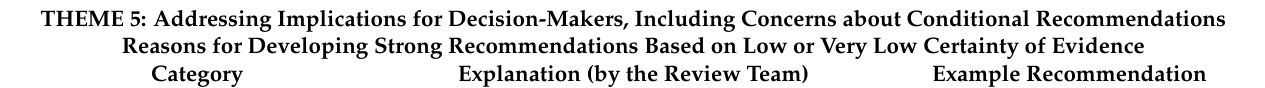
Table 4. Categories for theme 5 with example